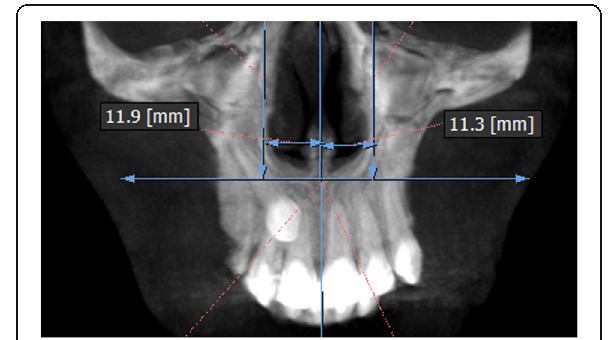
Fig. 3 Nasal cavity width. Measured in millimeters from the anterior nasal spine to the lateral wall of the nasal base on the side of the impacted canine and canine without